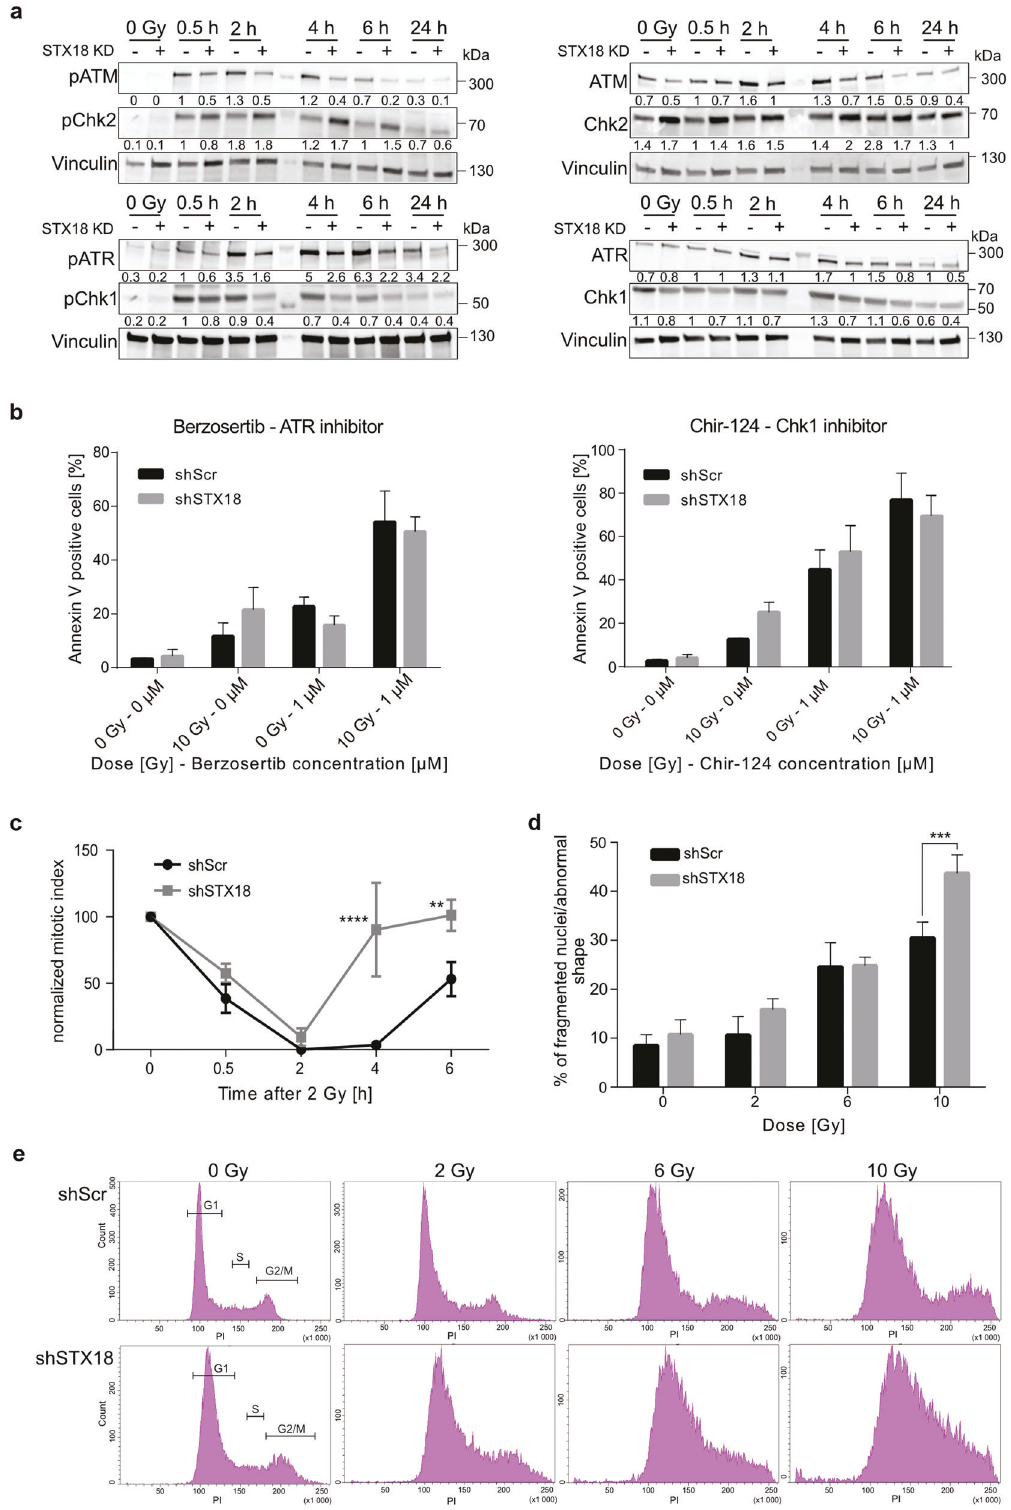
Fig. 4 STX18 knockdown leads to a defect in G2/M checkpoint in line with a premature entry into mitosis in A549 cells. For the representation of STX18 knockdown, A549-shSTX18 K3 cells were used. a Immunoblotting analysis of proteins involved in cell cycle checkpoints after 10 Gy. Vinculin was used as control. After normalization to the loading control, the samples were compared to the shScr- 0.5 h sample. b Detection by fl ow cytometry of Annexin V positive cells following irradiation with 10 Gy and/or pre-treatment with 1 µM berzosertib or Chir-124. Cells were incubated for 72 h then stained with Annexin V. c Quanti fi cation of mitotic index after irradiation with 2 Gy by quanti fi cation of cells positive for phosphorylation of Histone H3 by fl ow cytometry. d Quanti fi cation of fragmented nuclei and nuclei with abnormal shape in the cell population 72 h after irradiation. e Cell cycle analysis by fl ow cytometry after irradiation. Cells were irradiated and cell cycle distribution was analyzed by PI staining after 72 h. n = 3 for all experiments. Cell Death and Disease (2022)